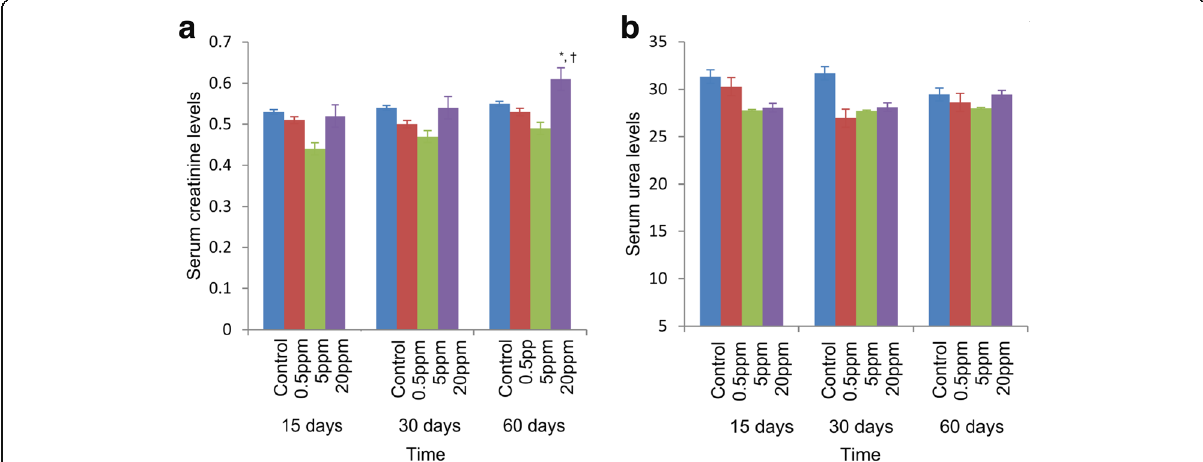
Fig. 3 Effects of fluoride on serum creatinine and urea in rats after 15, 30, and 60 days. a Serum creatinine levels. b Serum urea levels of rats exposed to distilled water and different concentrations of fluoride (0.5, 5, and 20 ppm) for 15, 30, and 60 days. * p <0.05 compared with 0.5 ppm; † p <0.05 compared with 5 ppm. Error bars represent standard error